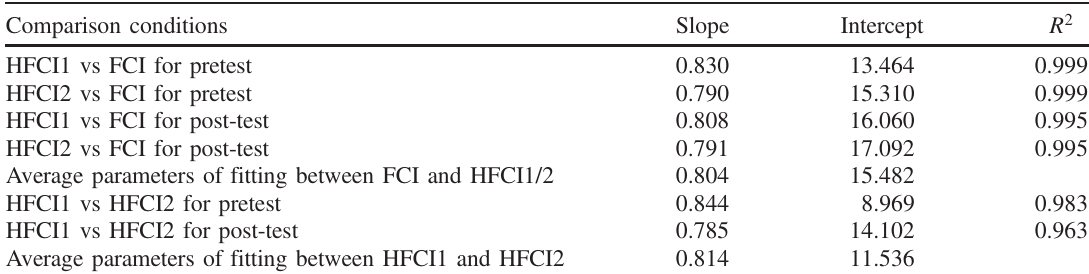
TABLE IV. Parameters of the linear fits between any two of the three tests on both pre- and post-tests. Comparison conditions